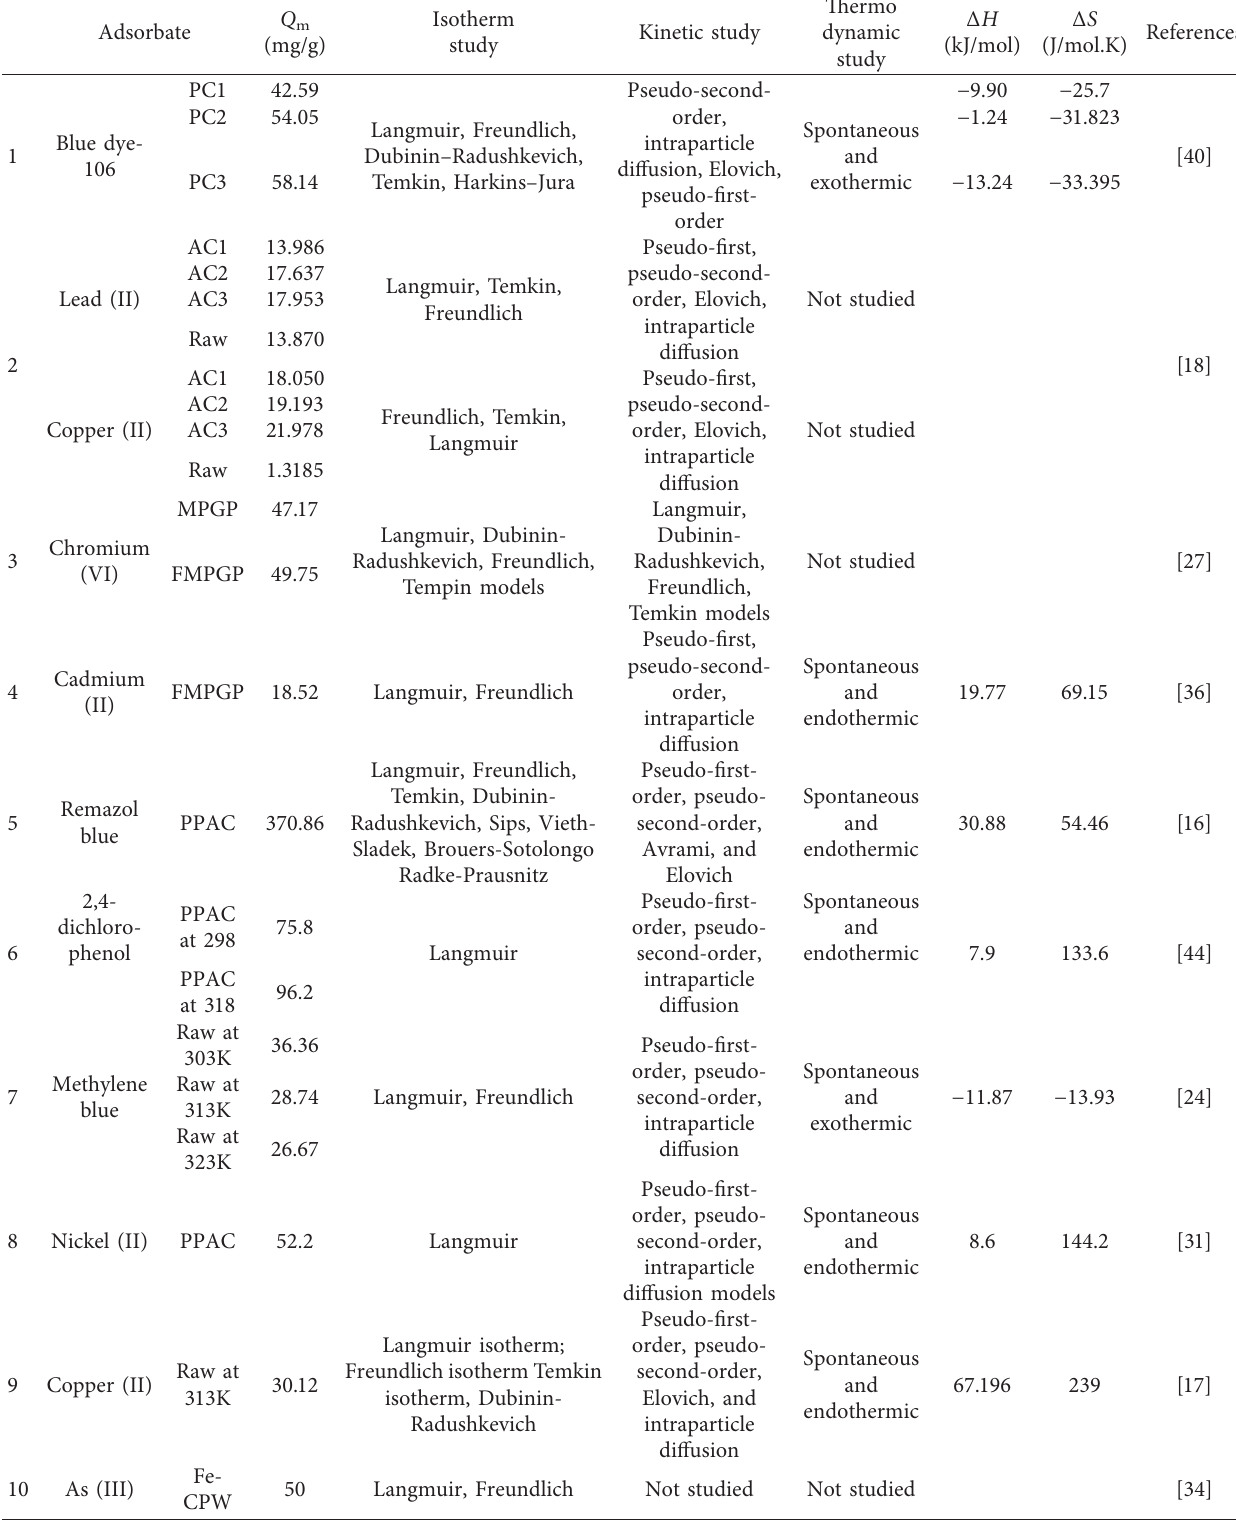
Table 2: Biosorption operating conditions of different pollutants from the literature by pomegranate peel biosorbent.